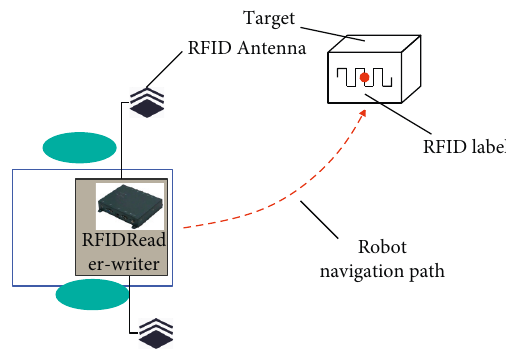
Figure 6: Navigation diagram of RFID servo